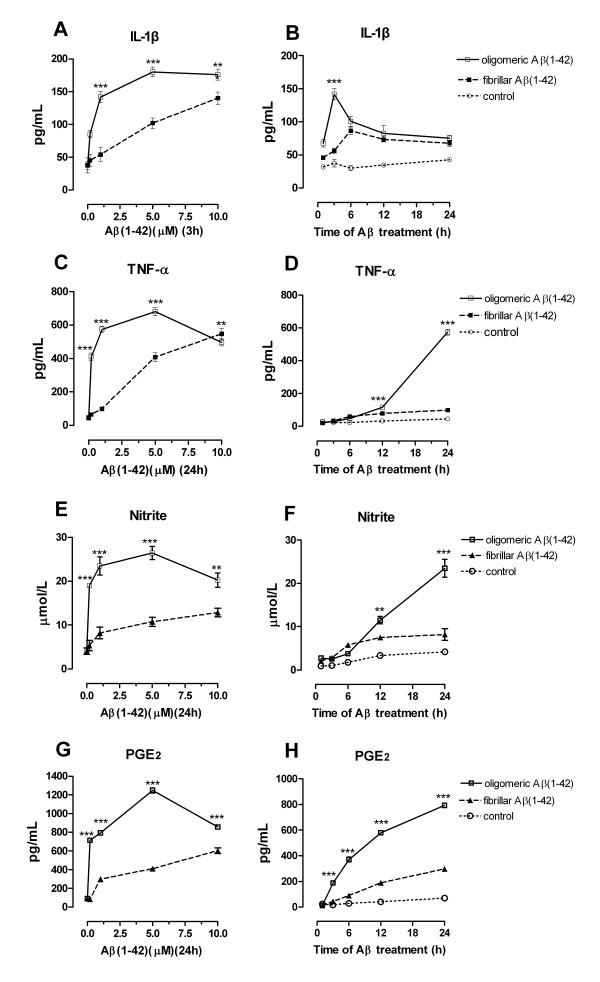
Time course and dose response of inflammatory mediators induced by two types of Aβ(1-42) in microglial cells. BV-2 cells were stimulated with two types of Aβ(1-42) (1.0 μM) for 1, 2, 3, 6, 12, 24 h. Or cells were stimulated with the Aβ(1-42) (0.2~10 μM) for indicated time (TNF-α, NO and PGE2 for 24 h, or IL-1β for 3 h), then the supernatant was collected for ELISA, EIA or Griess analysis, respectively. Values are shown as mean ± S.E. **P < 0.01 or ***P < 0.001, oAβ versus fAβ groups.